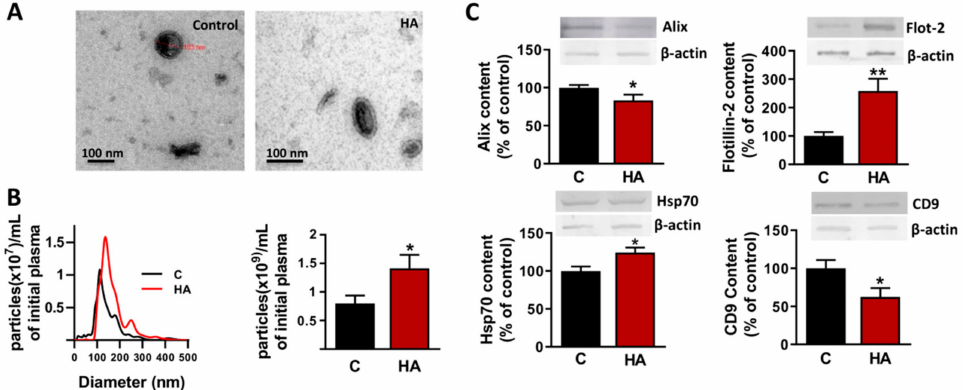
Figure 2. Characterization of extracellular vesicles isolated from plasma of control and hyperammonemic rats. ( A ) Representative images obtained by Transmission Electron Microscopy after negative staining. ( B ) Content of markers Alix ( n = 16), Flotillin-2 ( n = 7), Hsp70 ( n = 20) and CD9 ( n = 12) analyzed by Western blot. Values are expressed as percentage of protein cargo in control rats and are the mean ± SEM. Data were analyzed by t-test, with values significantly di ff erent from control rats indicated by asterisk (* p < 0.05, ** p < 0.01). ( C ) Representative size profile and number of particles obtained by Nanoparticle tracking analysis. Values of particle quantity are the mean ± SEM of 15–18 samples per group. Data were analyzed by t-test, with values significantly di ff erent from control indicated by asterisk (* p < 0.01). We assessed if hyperammonemia alters the protein cargo of EVs by performing a proteomic analysis. After Uniprot mammalia library with False Discovery Rate (FDR) identification and analysis of individual SWATH experiments 367 proteins (FDR < 1%) were quantified in the 16 samples. Di ff erential expression analysis identified 124 proteins which content was di ff erent in EVs from HA or control rats. 44 proteins (12% of total) were up-regulated, 80 proteins (22% of total) were down-regulated, and 242 proteins (66% of total) remained unaltered (Figure 3A). The di ff erentially expressed proteins identified are listed in Table